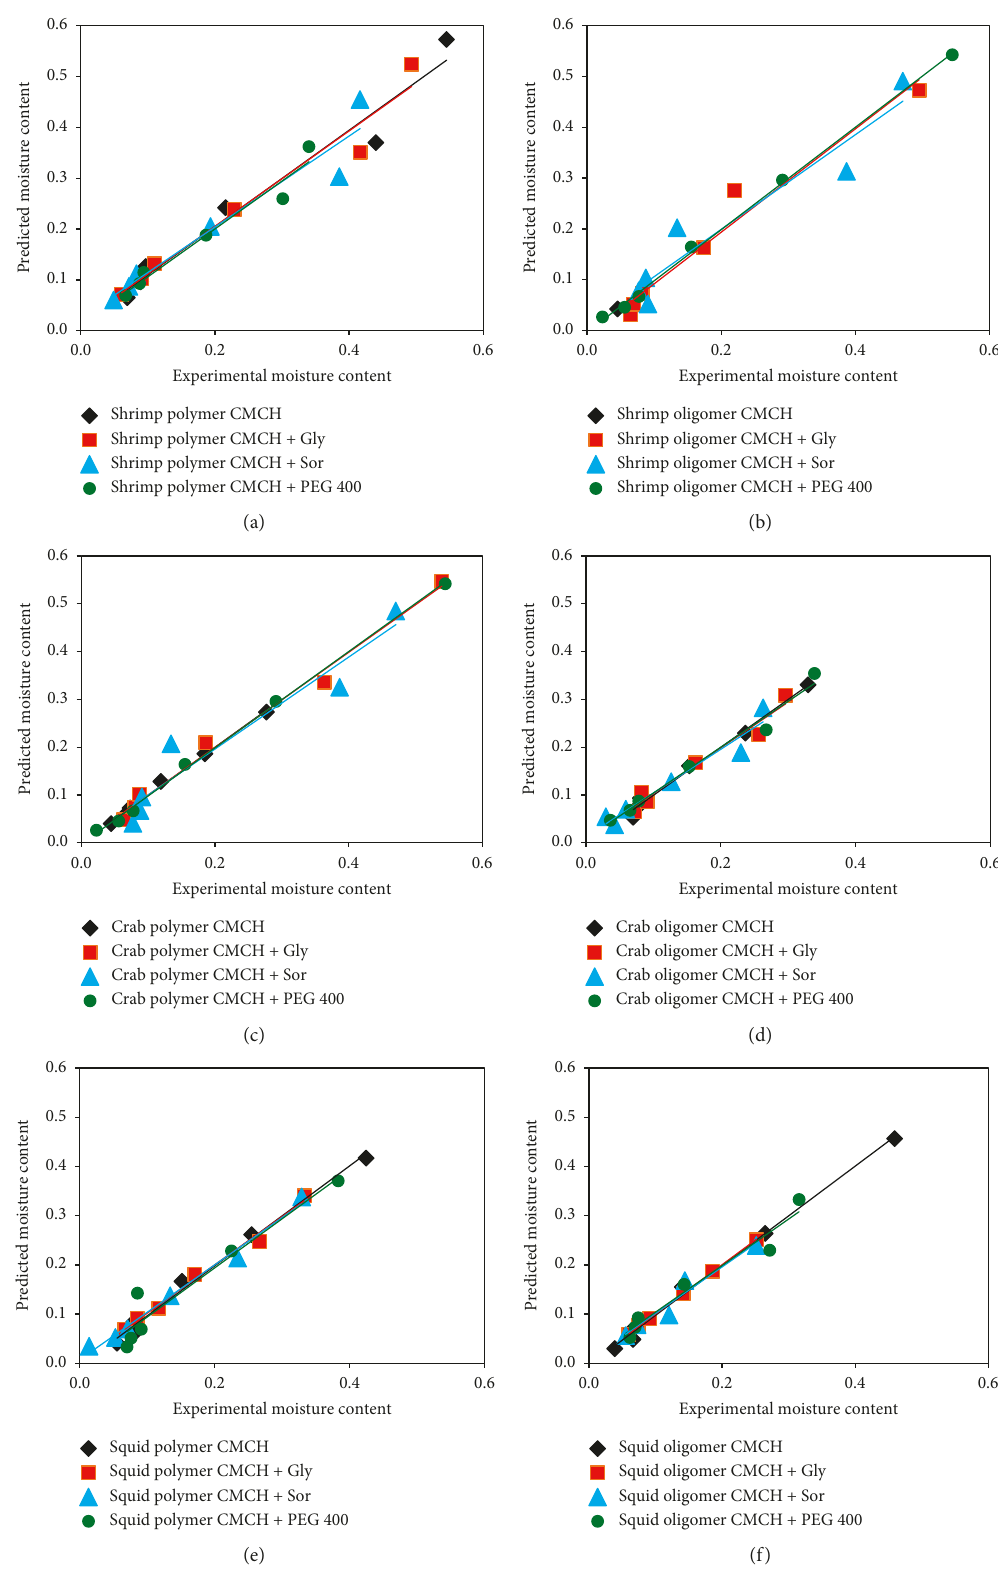
Figure 3: The comparison between the experimental moisture content values and those predicted for all the CMCH films from the Oswin model: shrimp polymer CMCH films (a); shrimp oligomer CMCH films (b); crab polymer CMCH films (c); crab oligomer CMCH films (d); squid polymer CMCH films (e); squid oligomer CMCH films